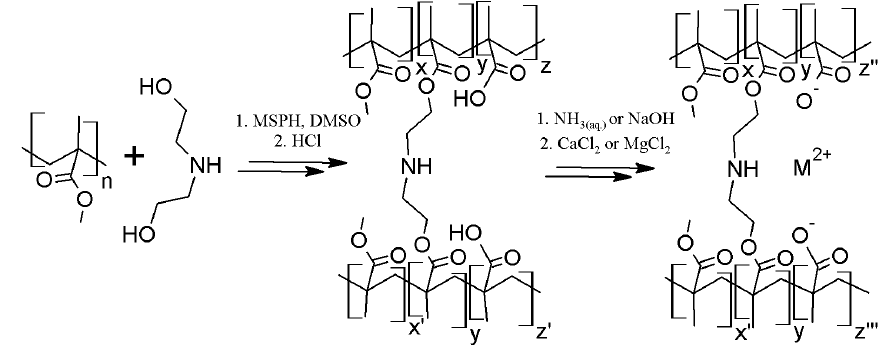
Figure 7. A scheme of reactions of the polymer matrices and sorbents preparation with their hypothetical structure. M 2 + —calcium or magnesium ion.